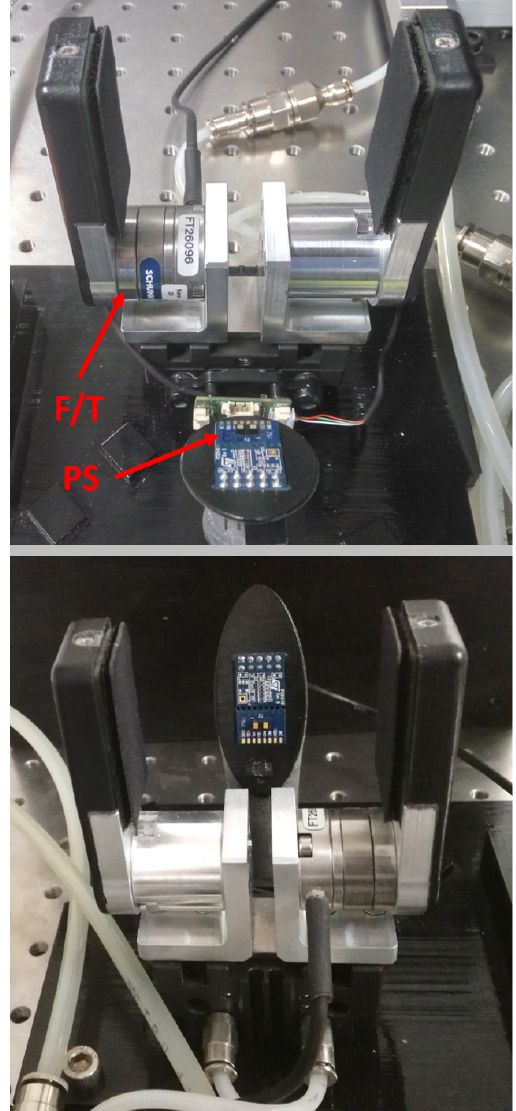
Figure 4. Smart gripper prototype: ( top ) rear view; and ( bottom ) front